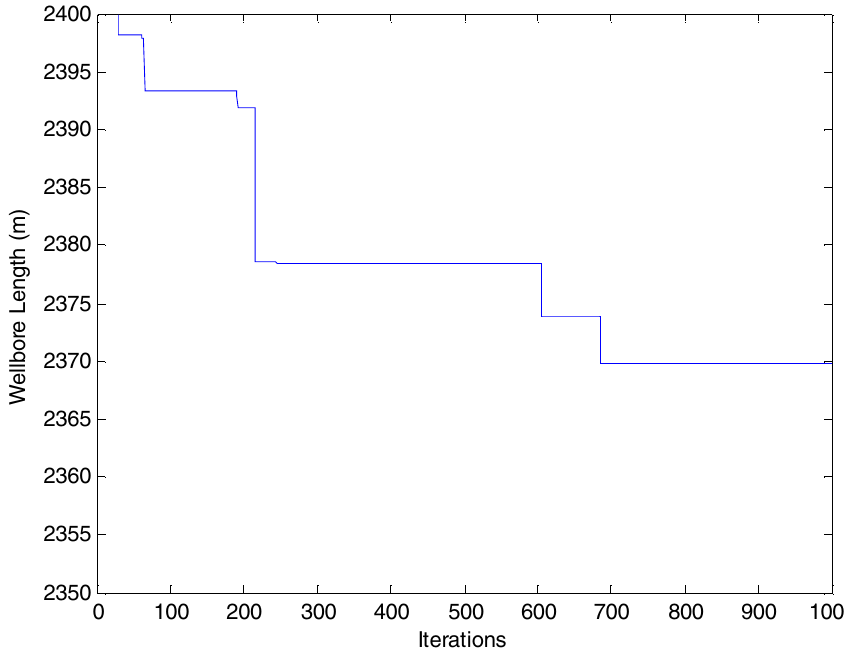
Fig. 8 The ACO algorithm behavior with 10 ants and 1000 iterations that takes about 150 s to complete (Case